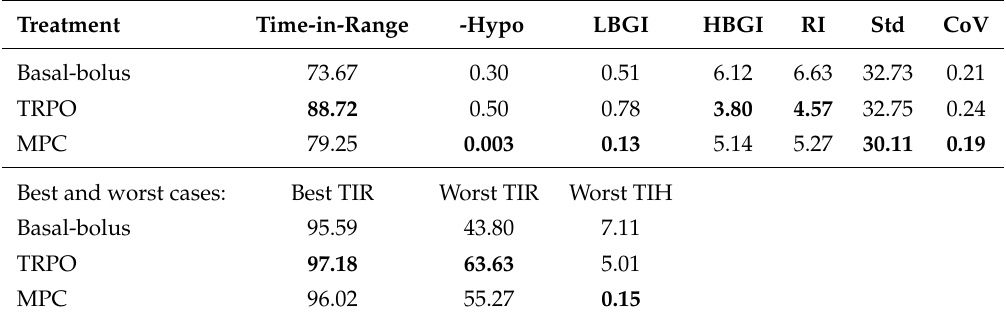
Figure 8. Kernel density estimate showing the approximate distribution of the same mean maxima and minima shown in Figure 7. The axes have been increased with respect to Figure 7 to fully cover the tails of the distributions. Table 2. Mean performance measures for all 100 patients with all 100 test meal scenarios. Best results for each category is marked bold. For time-in-range, higher is better, for all other measures, lower is